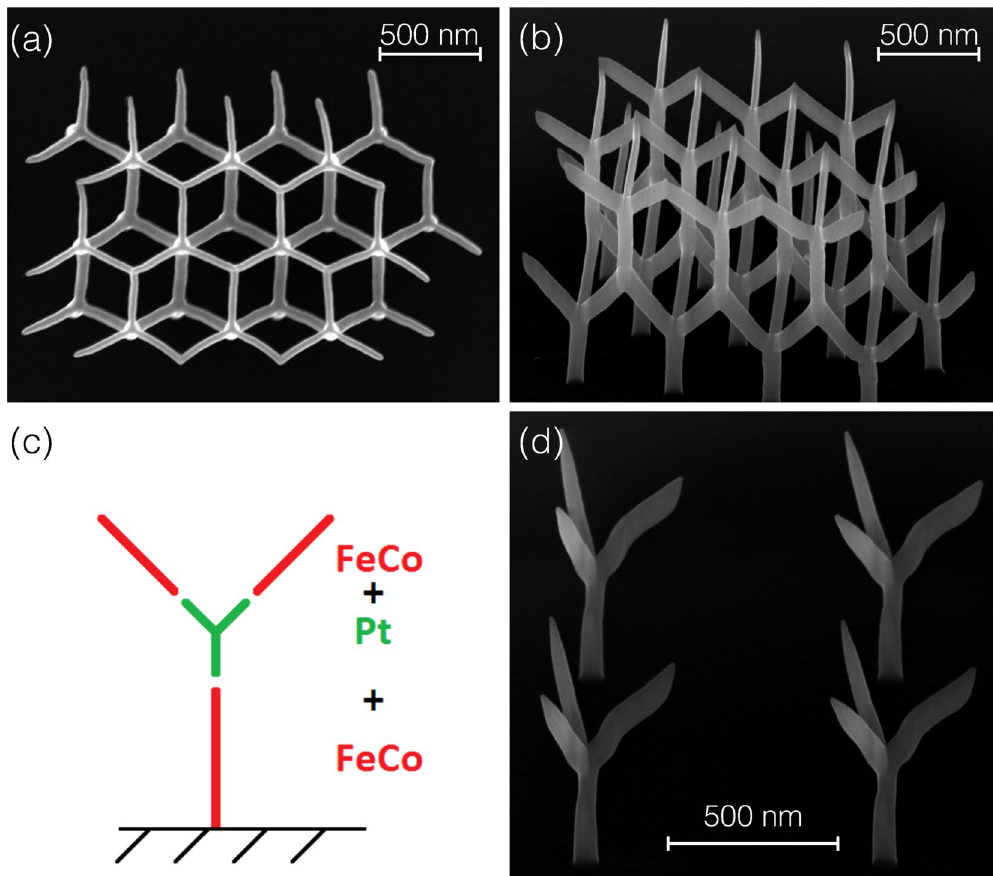
Figure 7. 3D array of nano-trees and nano-tree with non-magnetic vertex. ( a ) SEM top view of 3D nano-tree array fabricated by FEBID with the precursor HCo 3 Fe(CO) 12 . ( b ) Tilted view of the same array. ( c ) Schematic of nano-tree for which the vertex part is replaced by a non-magnetic segment consisting of nano-granular platinum Pt(C). ( d ) SEM image of a 2 × 2-array of nano-trees with FeCo stems and edges and non-magnetic Pt(C) vertex